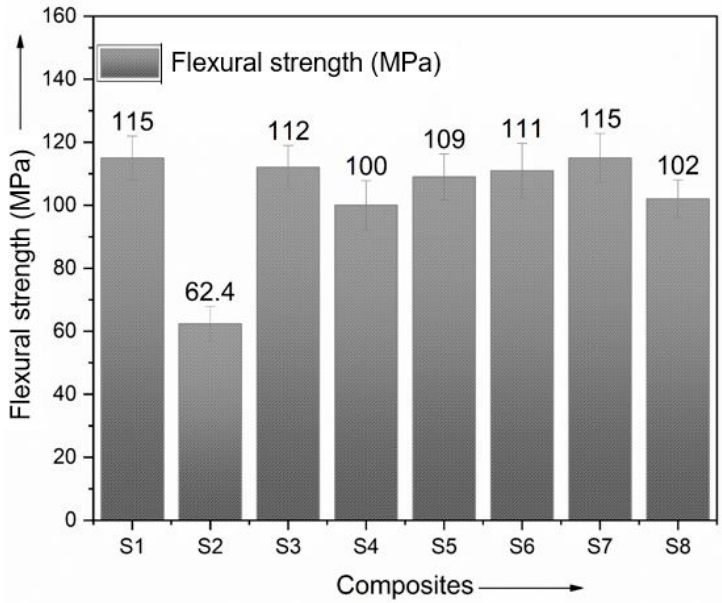
Figure 10. Comparison of flexural strength.